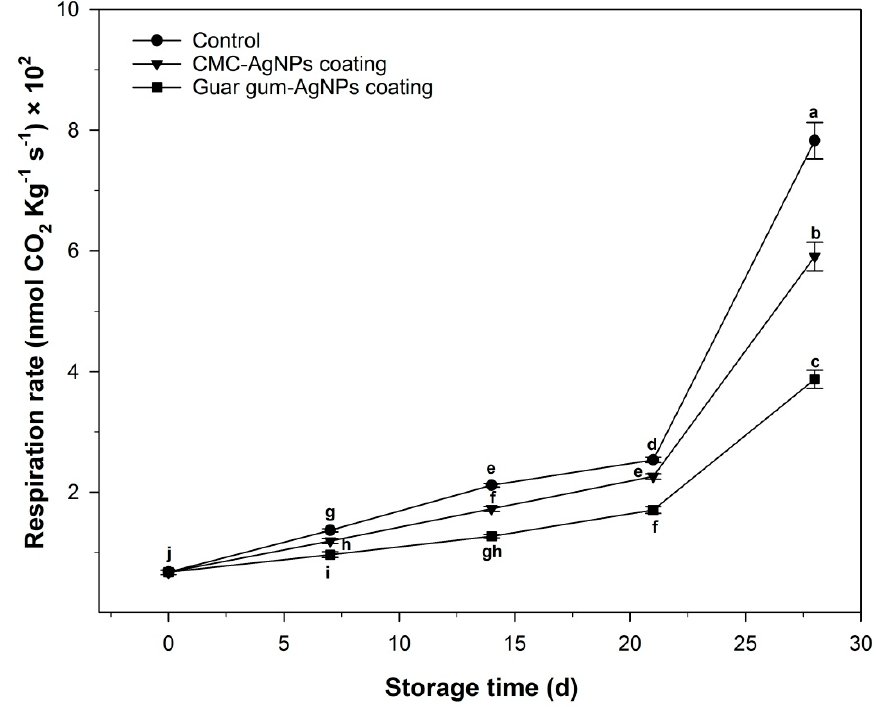
Figure 6. Effect of CMC-AgNP and guar gum-AgNP coatings on respiration rate of “Seddik” mango fruits stored at 13 °C for 4 weeks. Vertical bars represent the SE of means. Means with the same letter are not significantly different according to Duncan’s multiple range test ( α ≤ 0.05).